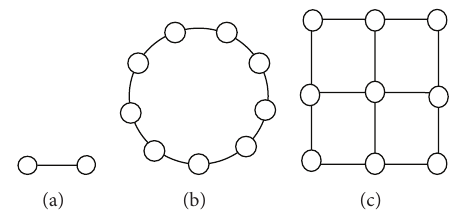
Figure 16: Membrane potential of two coupled MCs when con- nected to ring-like neuronal network of GCs.